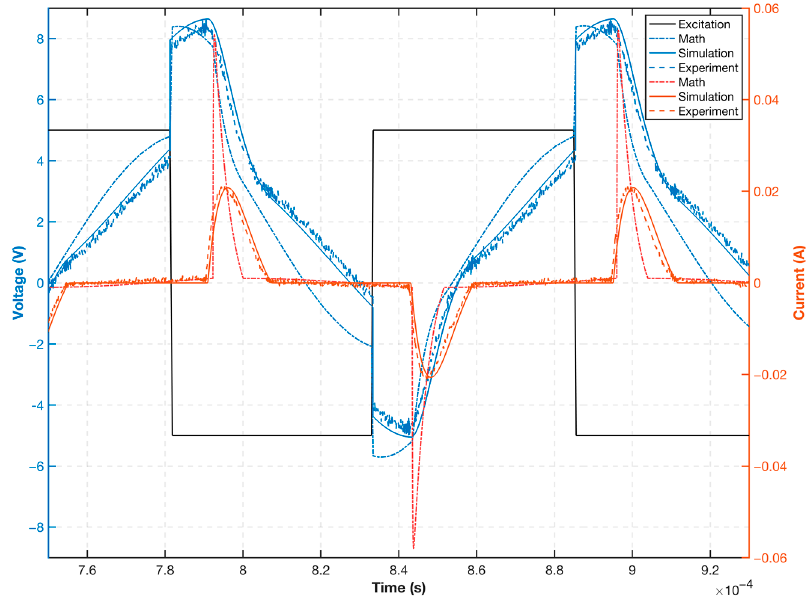
Figure 11. Mathematical, simulated, and experimental excitation circuit voltage and current wave- forms.